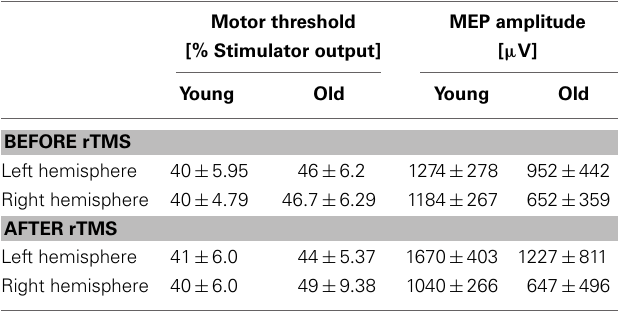
Table 2 | Measures of bilateral cortio-spinal reactivity and